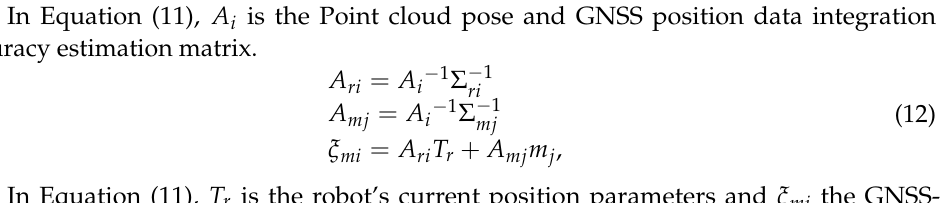
T is the robot’s current position parameters and r